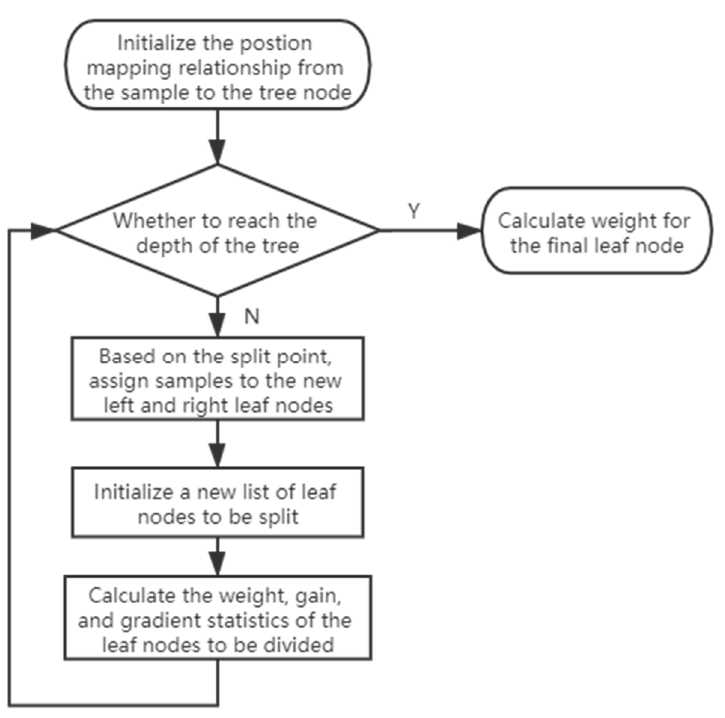
Figure 4. XGBoost algorithm flow.